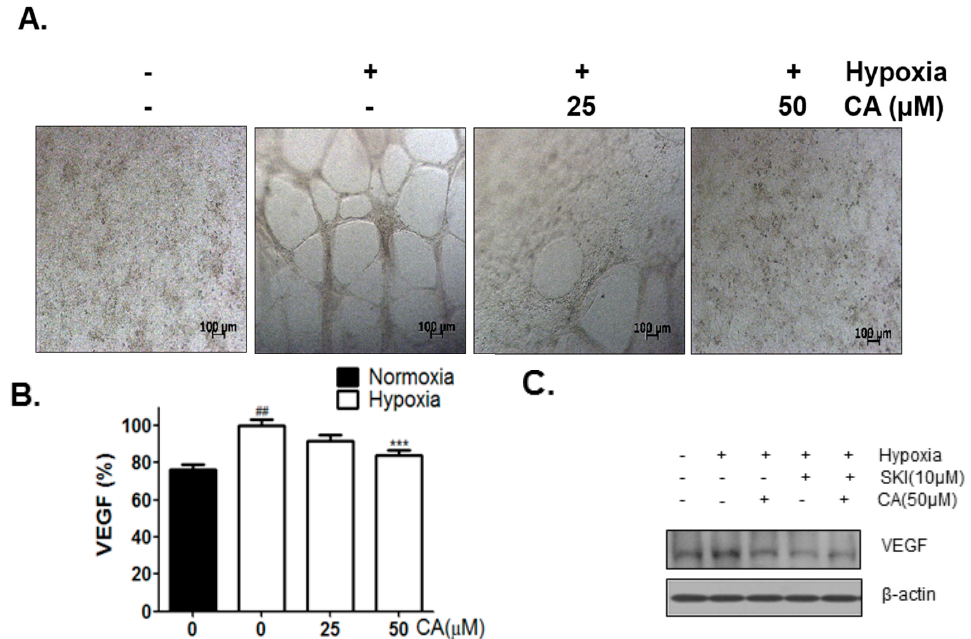
Figure 4. Inhibitory effect of CA on angiogenesis in DU145 cells under hypoxia for 24 h. ( A )